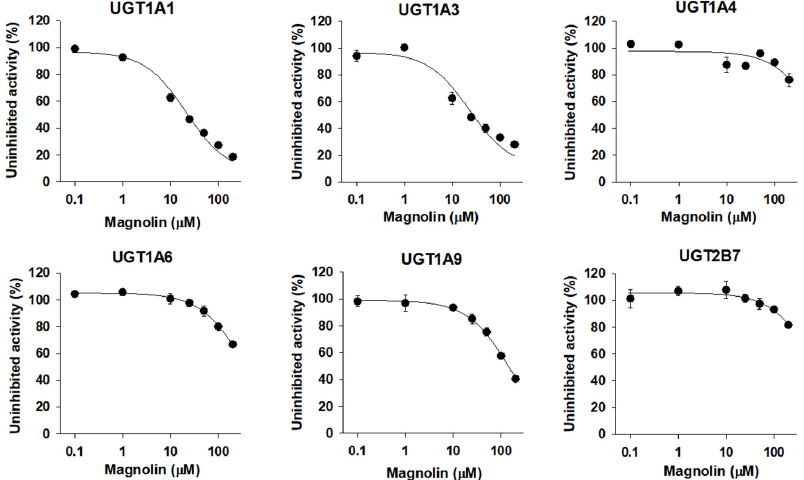
Figure 5. Inhibitory effects of magnolin (0.1–200 µ M) on UGT1A1-, UGT1A3-, UGT1A4-, UGT1A6-, UGT1A9-, and UGT2B7-mediated glucuronidation of 0.5 µ M SN-38, 2 µ M chenodeoxycholic acid, 0.5 µ M trifluoperazine, 1 µ M N -acetylserotonin, 0.2 µ M mycophenolic acid, and 1 µ M naloxone, a probe substrate for UGT1A1, UGT1A3, UGT1A4, UGT1A6, UGT1A9, and UGT2B7, respectively, in human liver microsomes. The data are expressed as means ± standard deviations ( n = 3).